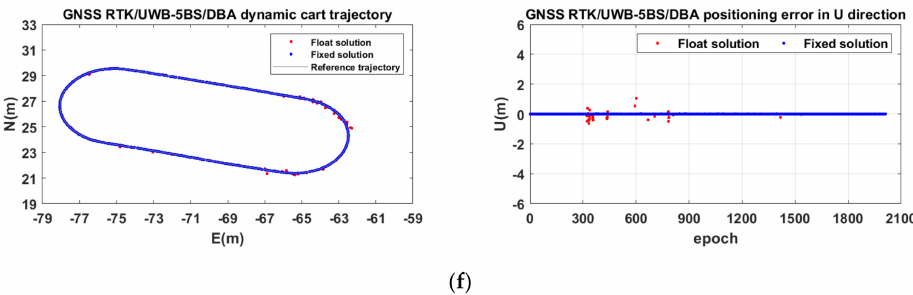
Figure 10. GNSS RTK/UWB/DBA fusion positioning model dynamic cart trajectory in the plane di- rection and positioning error in the U direction at a 30 degree elevation mask angle: ( a ) GNSS